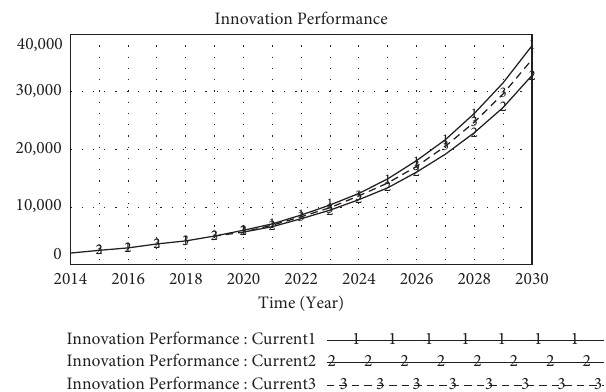
Figure 10: The influence of value factors adjustment on innovation performance.